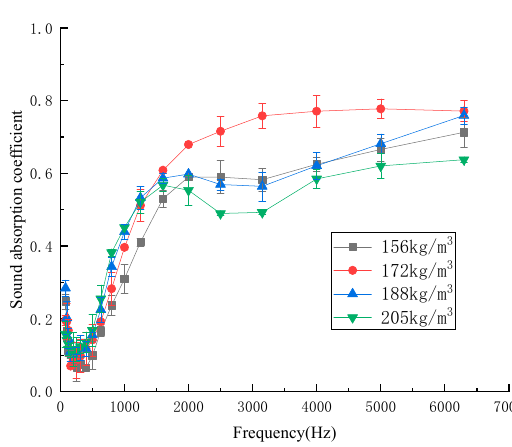
Figure 5. Sound absorption coefficient with different densities.